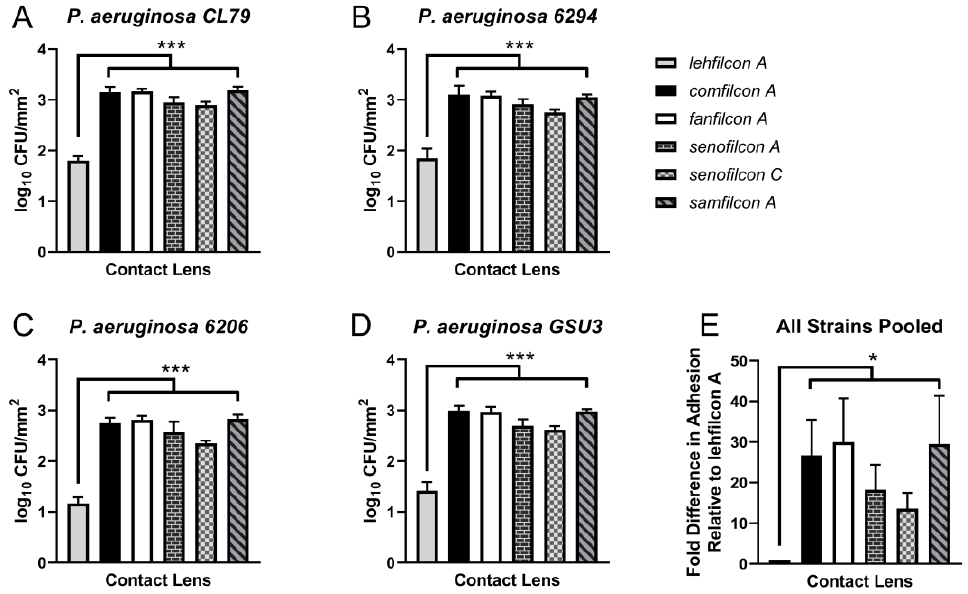
Figure 3. Lehfilcon A’s performance was consistent for various strains of P. aeruginosa . ( A – D ) Quanti- tative adhesion assays of P. aeruginosa strains GSU3 ( A ), CL79 (B), 6294 ( C ), and 6206 ( D ) exposed to soft contact lenses (n = 6 per lens type). The data are depicted as the average log density of CFUs recovered from adhesion reactions (log 10 CFU/mm 2 ) ± S.D. ( E ) Fold difference in P. aerugi- nosa adhesion for each lens material relative to lehfilcon A. The data depicts the pooled mean fold difference ± S.D. for all five quantified P. aeruginosa strains (10145, GSU3, CL79, 6294, and 6206). * represents p < 0.05, *** represents p < 0.0005 for comparison to lehfilcon